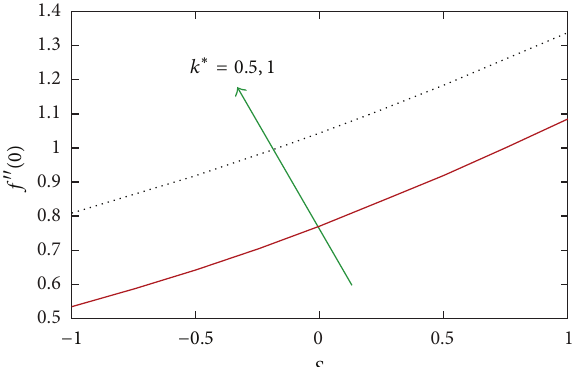
Figure 9: Local skin friction coefficient 𝑓 󸀠󸀠 (0) versus 𝑆 for different values of 𝑘 ∗